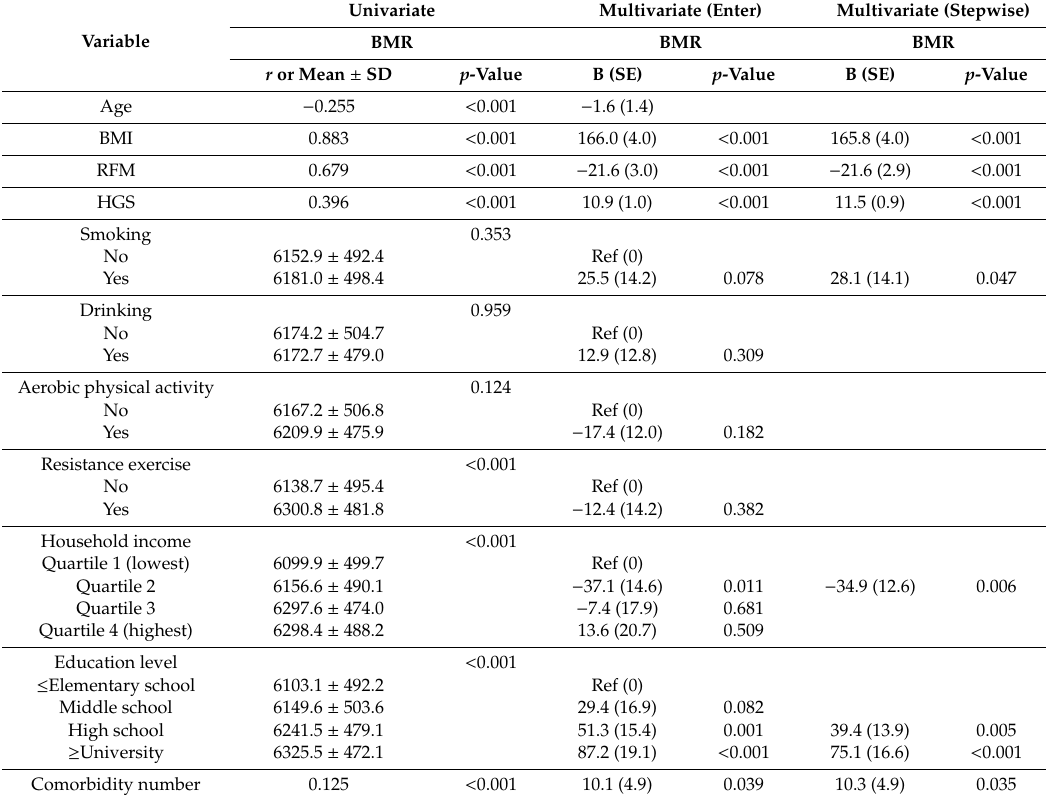
Table 3. Univariate and multivariate linear regression analysis of basal metabolic rate and studied variables in